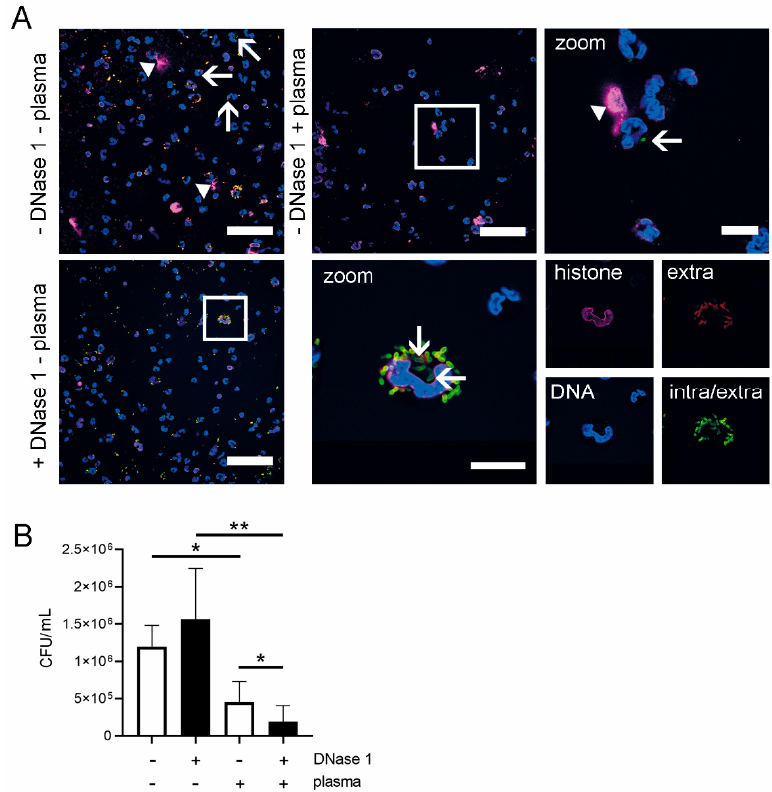
Figure 8. DNase 1 improves killing of S. suis by neutrophils in the presence of plasma. ( A ) Immunofluorescence staining of NETs and intra- and extracellular S. suis . NET production and phagocytosis exist in parallel during neutrophil killing assay. With plasma, less bacteria can be seen than without plasma. More Streptococci are extracellular than intracellular as the single channels visualize (blue = DNA (Hoechst); magenta = DNA/histone1-complexes (NETs, white arrowheads); red and green = extracellular S. suis ; green = intracellular S. suis (white arrows)). Representative pictures are shown (scale bar = 50 µm, zoom = 10 µm). ( B ) The effect of DNase 1 on killing of S. suis 10 cps Δ EF was proven with a neutrophil killing assay with or without 10% plasma of the blood- donating pig. After 2 h incubation with plasma, an increased killing of S. suis was detectable with DNase 1. Without plasma, the CFU/mL was significantly higher than with plasma. The best killing effect was detectable with plasma and DNase 1. Data shown as mean ± SD, n = 5 independent experiments. Statistical analysis: paired students t -test (* p < 0.05, ** p < 0.01).